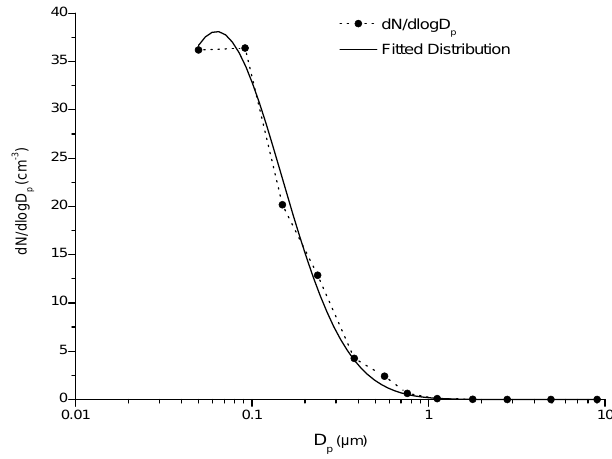
Fig. 9. Mean number size distribution for elemental carbon derived from size-segregated chemical analysis. The lognormal fit repre- sents an approximation of the existing data points. Its geometric mean diameter bears some uncertainty because of the open left-hand side of the distribution.